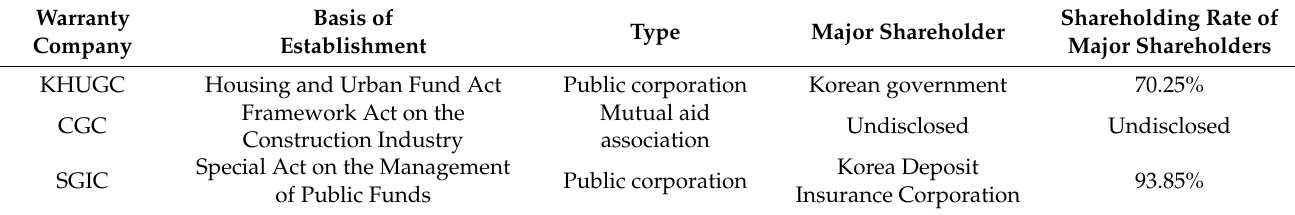
Table 2. Comparison of the Korean warranty